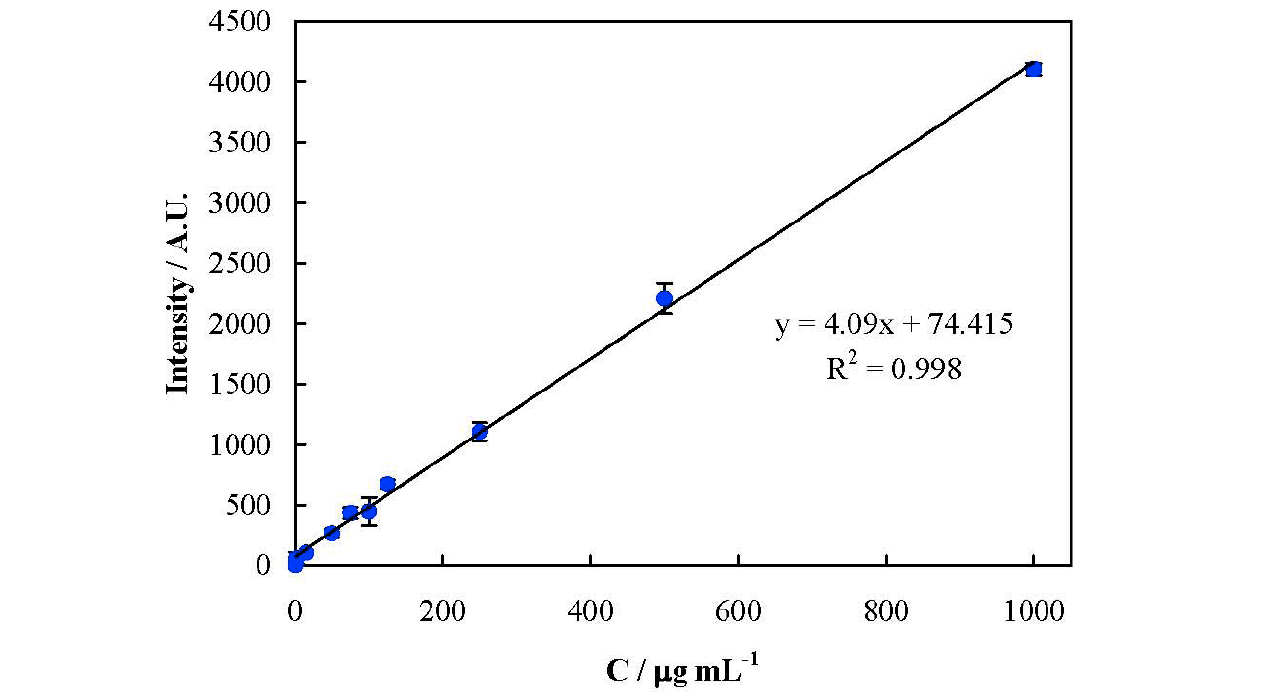
Figure 3 - Release profile of imatinib from the imatinib-loaded SNEDDS and an imatinib aqueous